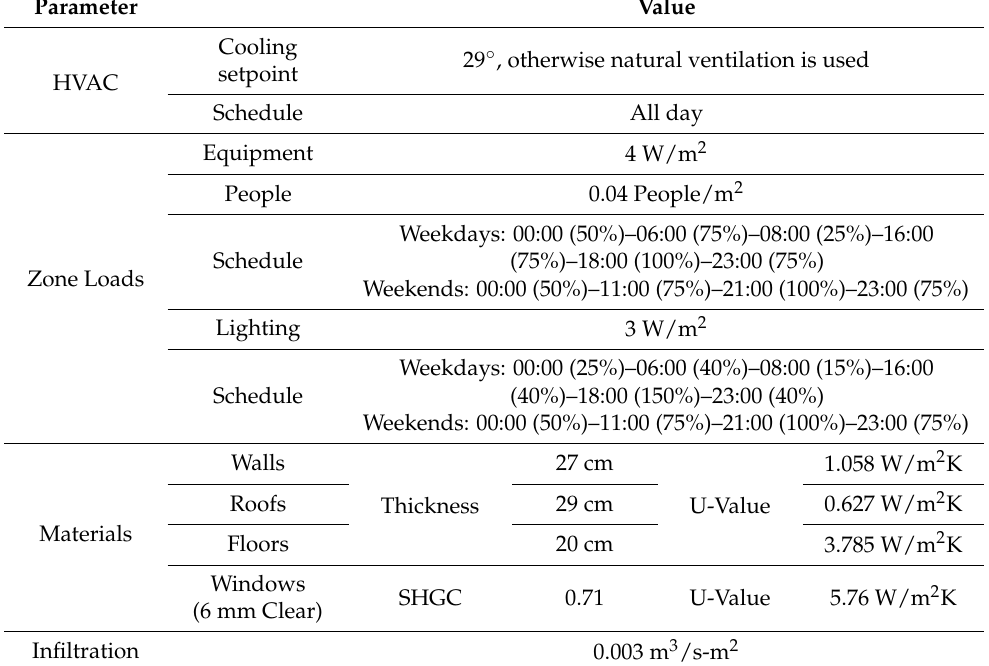
Table 2. Fixed simulation parameters used in the